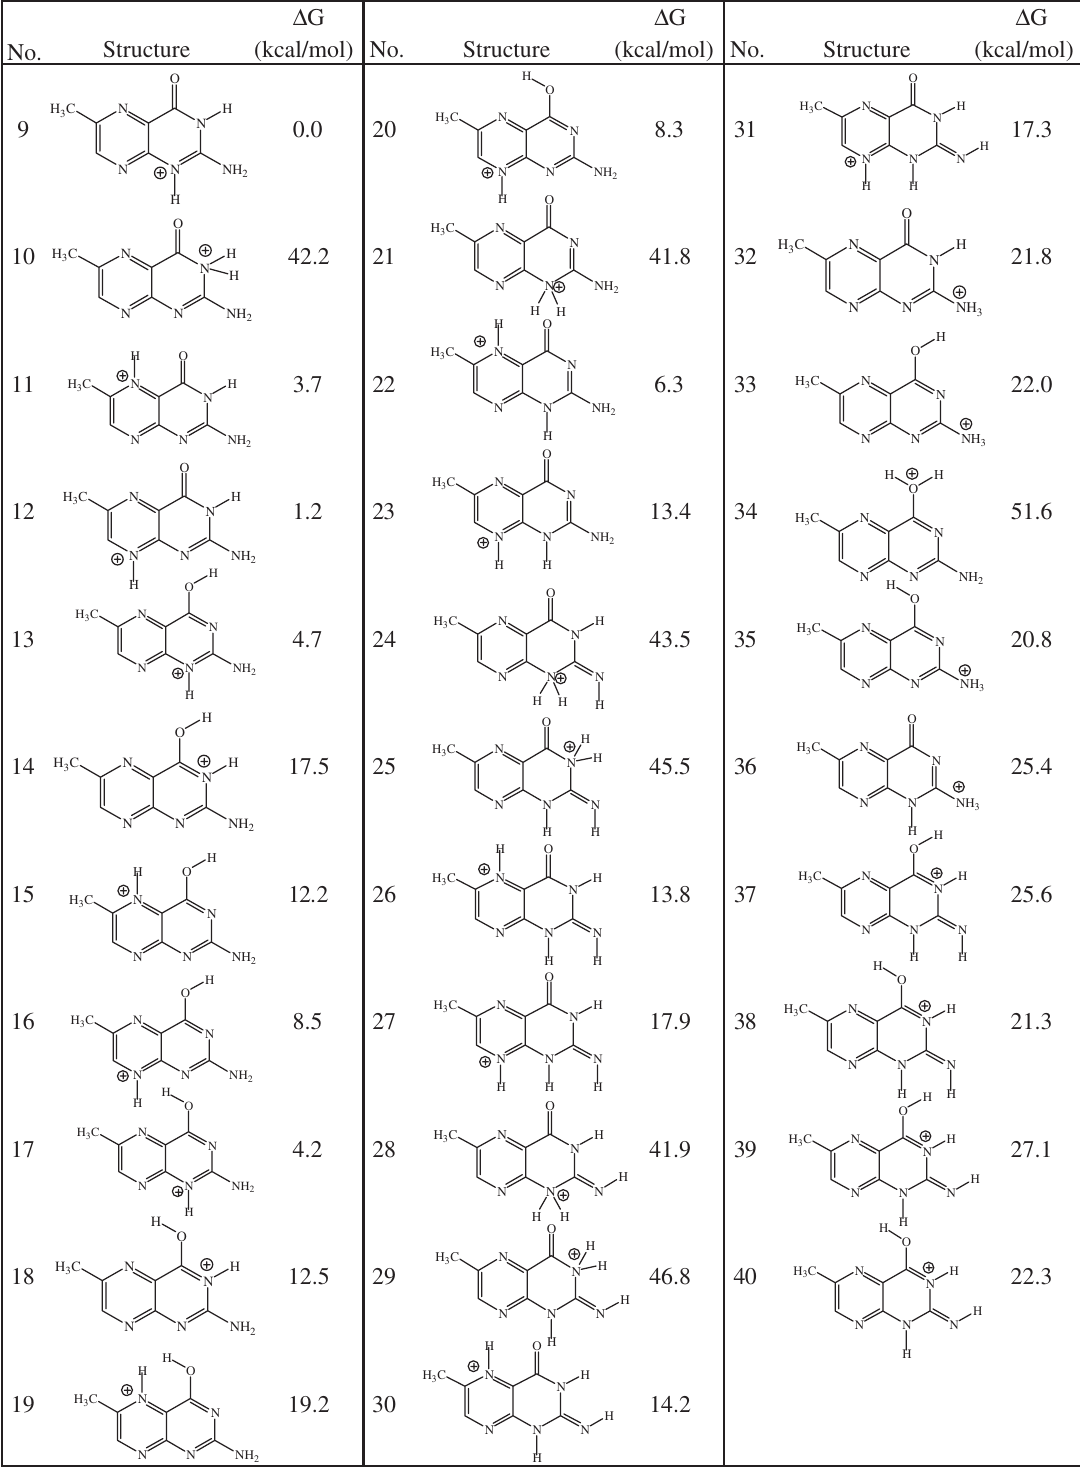
Table 1 Relative energies of various protonated pterins (B3LYP/6-31+G**, PCM solvation model with water dielectric). ∆ G ∆ G ∆ G No. Structure (kcal/mol) No. Structure (kcal/mol) No.